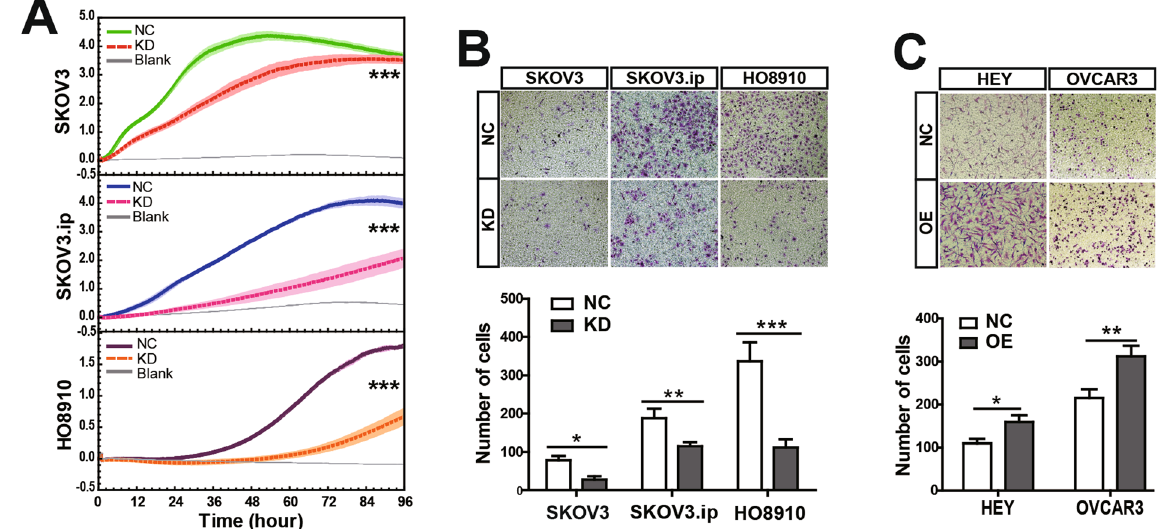
Figure 3. Study of functional characteristics of RAD51-AS1 in cell migration and invasion. ( A ), Migration assays. The real-time cell indexes indicated that RAD51-AS1 knockdown greatly decreased cell migration capacity compared with the NC cells. Blank control was performed with the bottom chamber containing RPMI 1640 but without FBS as a chemo-attractant. The light-colored error bars denote the SD. ( B ), Transwell invasion assays. RAD51-AS1 knockdown significantly decreased the invasive capacity of SKOV3, SKOV3.ip and HO8910 cells. ( C ) Overexpression of RAD51-AS1 increased cell invasion capacity of Hey and OVCAR3 cells. Each experiment was repeated in triplicate (n = 3). (The results are shown as the mean ± SD; * P < 0.05; ** P < 0.01; *** P < 0.001 by Student’s t